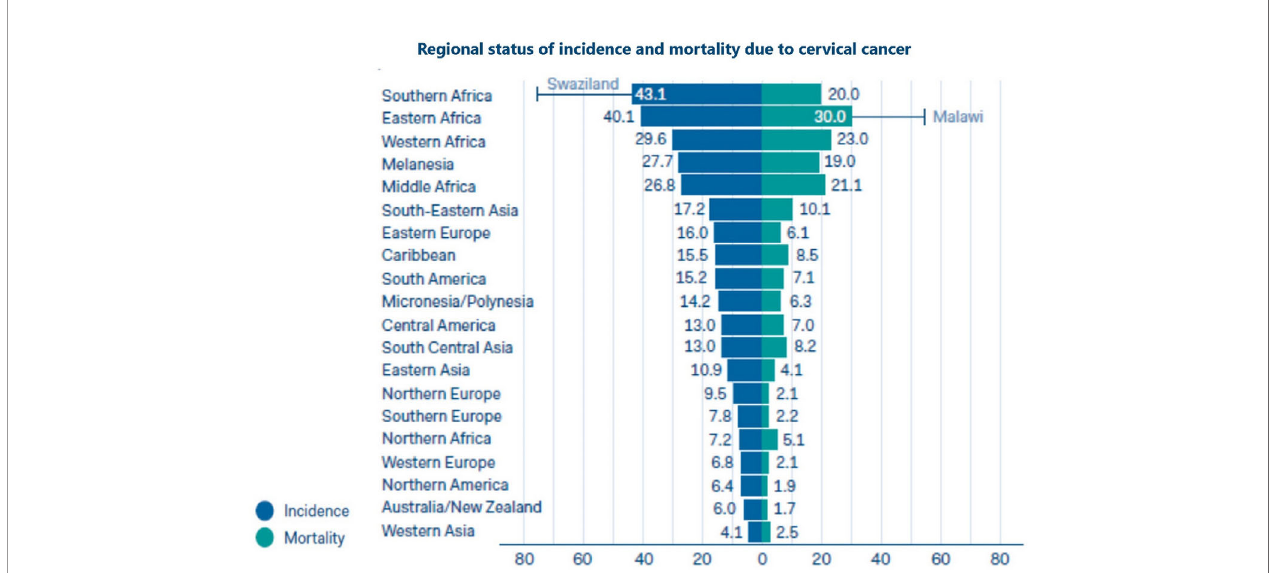
FIGURE 3 | Regional status of incidence and mortality due to uterine cervical cancer